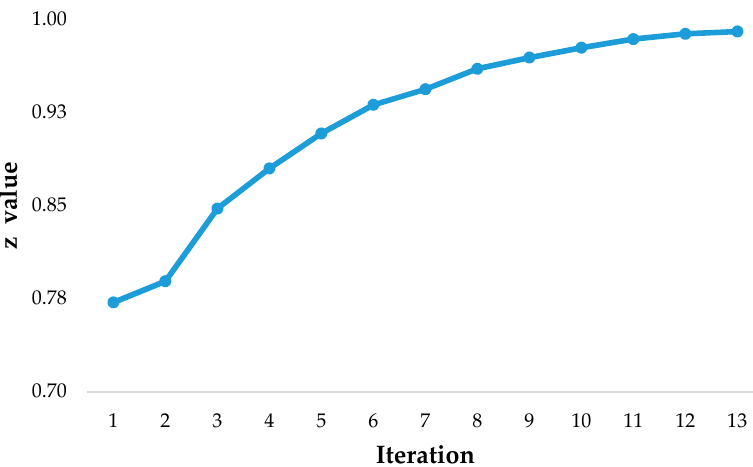
Figure 6. Least membership functions value at each iteration Case 2.